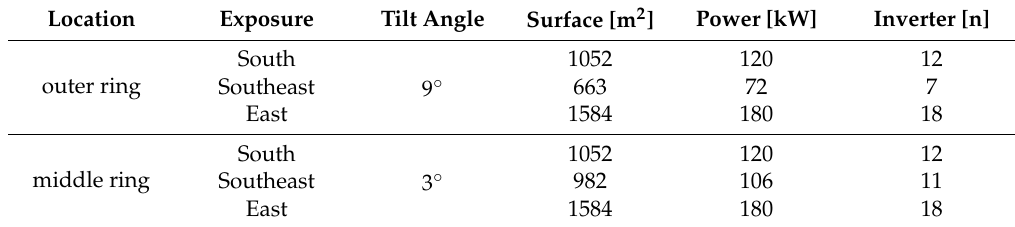
Figure 6. Design of the photovoltaic plant integrated on the roofing: from the left: ( a ) section; ( b ) plan. Table 10. Energy requirements for heating and cooling referred to each plant.